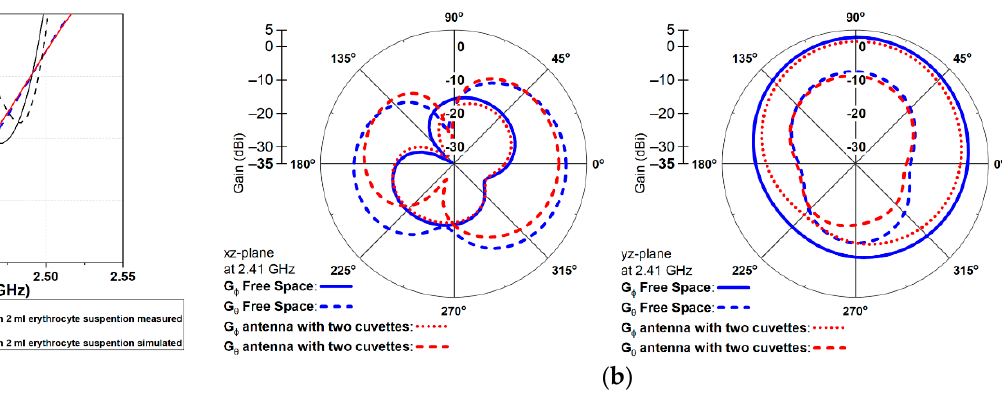
Figure 4. Antenna performance: ( a ) VSWR and ( b ) 2D radiation patterns in xz- and yz-plane. Table 2. Comparison of the FDTD-computed antenna parameters at 2.41 GHz, in two scenarios: antenna in the free space, and antenna with two cuvettes filled with erythrocyte suspension. Parameters Antenna in Free Space